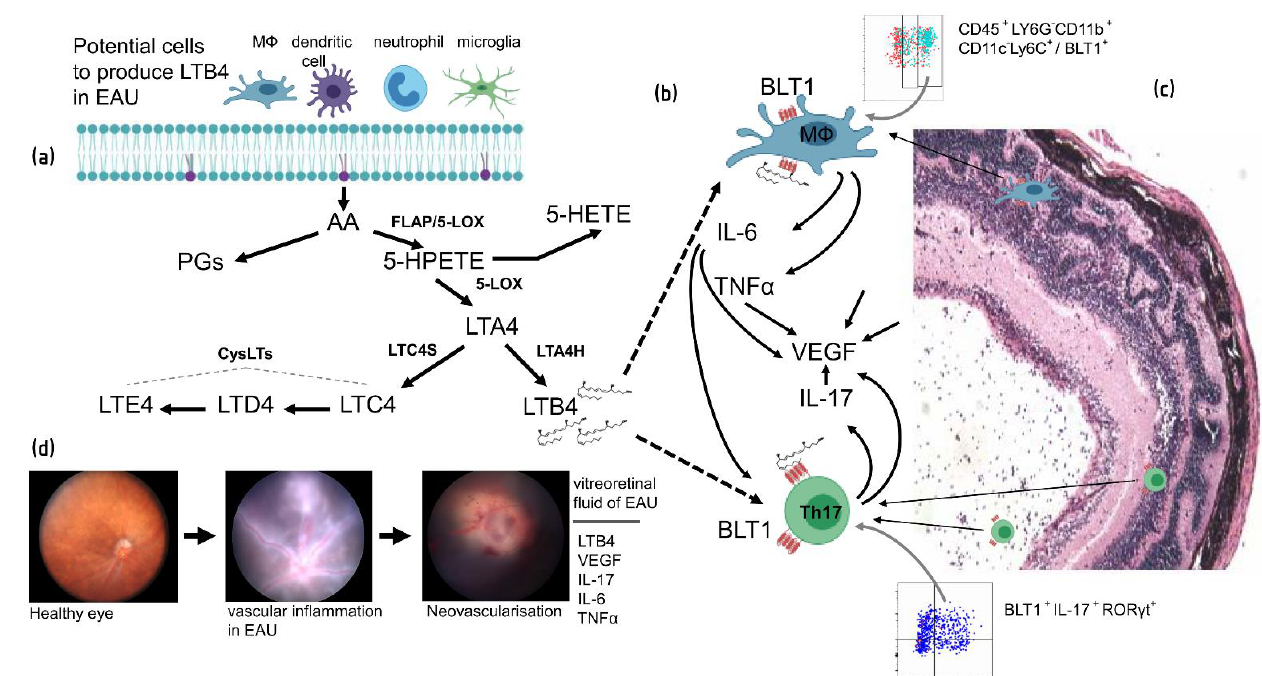
Figure 2. The schematic figure showing some of the microenvironmental conditions in the inflamed posterior eye in EAU with infiltrating immune cells and structural damage along with relevant inflammatory pathways. ( a ) A summary of biosynthesis of leukotriene B4 (LTB4) and cysLTs (LTC4, LTD4 and LTE4) from AA from potential immune cells in inflamed posterior chamber. ( b ) LTB4 interacts with LTB4 receptor (BLT1), a G Protein Coupled Receptor, on the infiltrating macrophages and also T cells and activates signalling pathways. Th17 cells produce cytokines including interleukin (IL)-17 and VEGF. Producing IL-6 and tumour necrosis factor-alpha (TNF α ) by activated macrophages also enhances VEGF expression. The speculated signalling through LTB4-BLT1 pathway which leads to production of VEGF in Th17 and infiltrating macrophages showed by dotted lines. ( c ) The Hematoxylin and Eosin section from EAU shows histological changes in the posterior chamber of the eye with infiltrating immune cells in vitreous space and structural damages in retinal layers. ( d ) Fundoscopy of healthy eye, inflamed eye (EAU) with vascular inflammation and sign of neovascularisation during EAU progression has been shown in this figure. O = optic disk, V = vessel, iO = inflamed optic disk, iV = inflamed vessel, nV = new